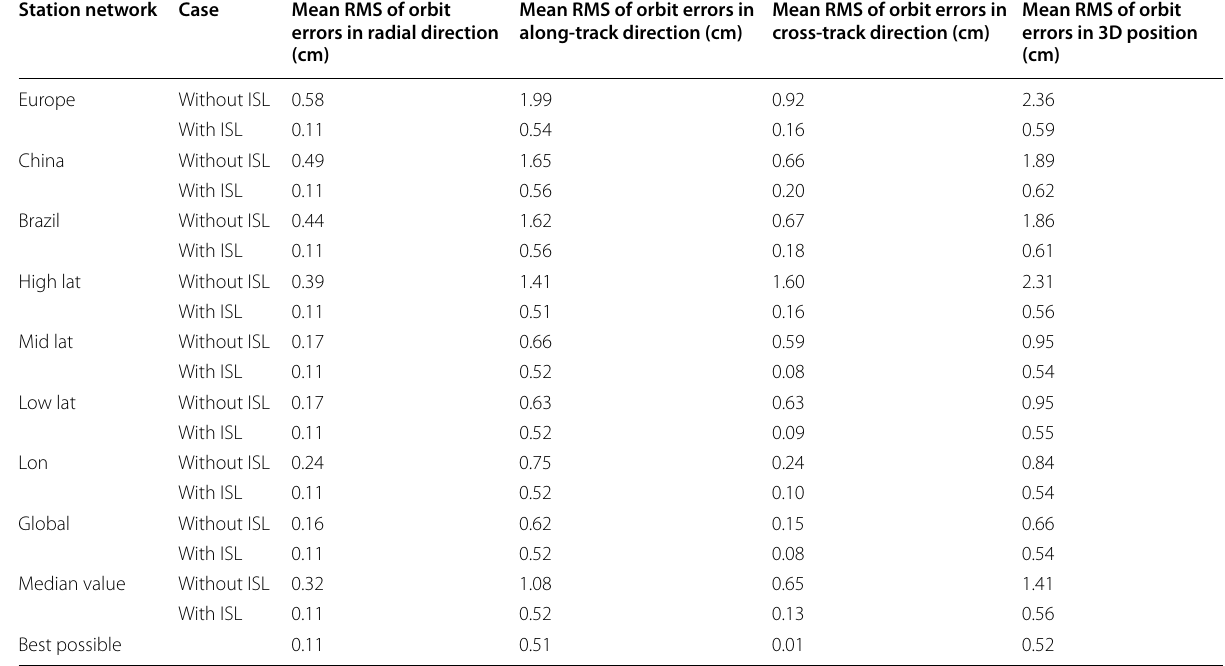
Table 2 Mean RMS of orbit errors in radial, along-track, cross-track and 3D position directions Station network Case